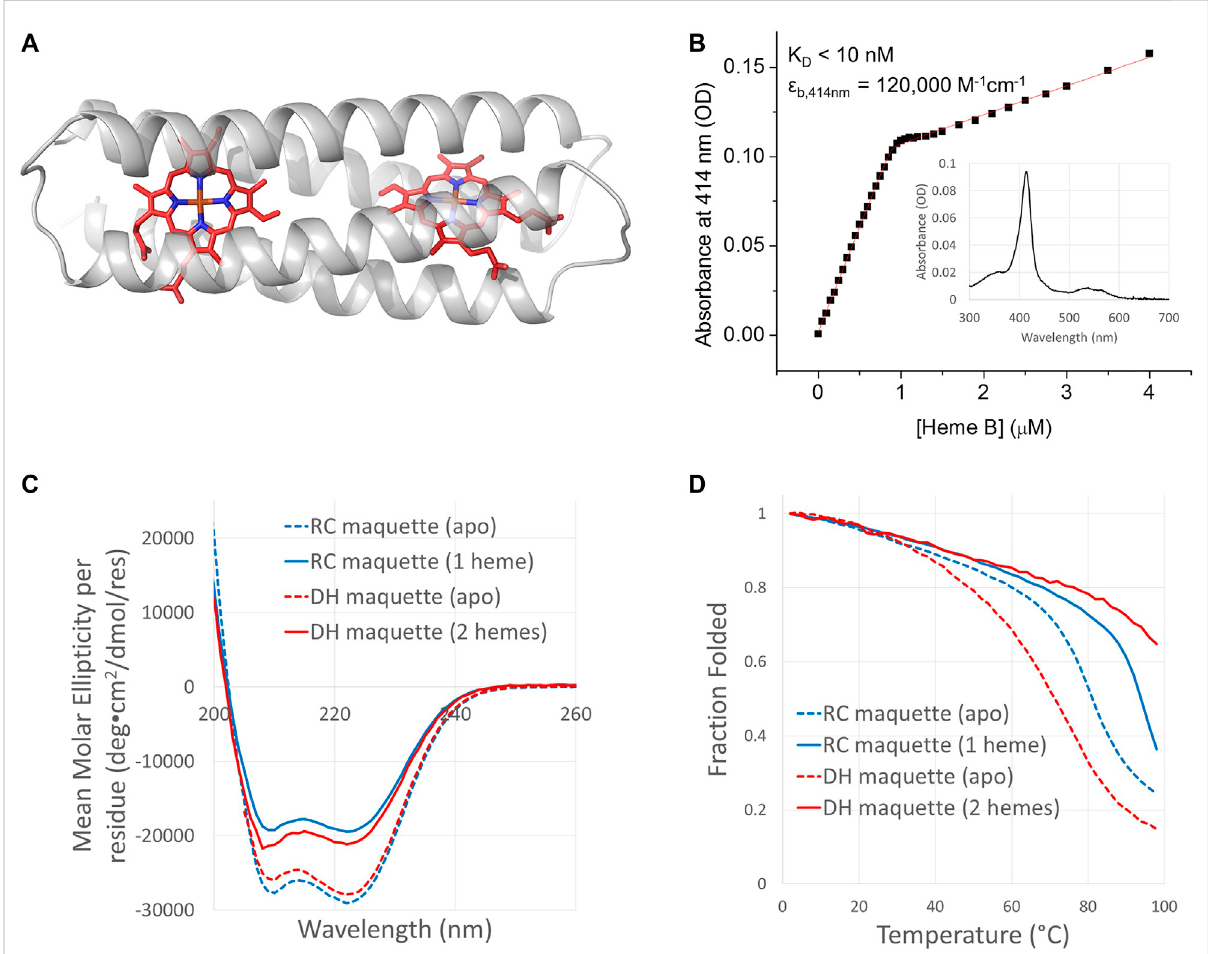
FIGURE 6 Design and function of the Di-Heme (DH) maquette. (A) DH maquette design model is based on crystal structure of RC maquette. (B) UV/vis bindingtitrationofferrichemeBinto0.5 µMDHmaquettewasmonitoredattheSoretmaximumat414 nm.Inset:Spectrumat0.8 molarequivalents of heme B per DH maquette protein. Conditions: 50 mM NaCl, 10 mM MOPS buffer, pH 7.5. CD spectra in panel (C) and thermal melts in panel (D) weremeasuredinsamplescontaining15 mMNaCland10 mMNaH 2 PO 4 atpH7.Hemebindingsigni fi cantlyincreasesthemeltingtemperature butlowerstheellipticityat222 nm.Proteinconcentrations wereasfollows:16.8 µMapo-RCmaquette(bluedashedcurves),20.3 µMRCmaquette- heme B (blue solid curves), 31.8 µM apo-DH maquette (red dashed curves), and 18.3 µM DH with two hemes B (red solid